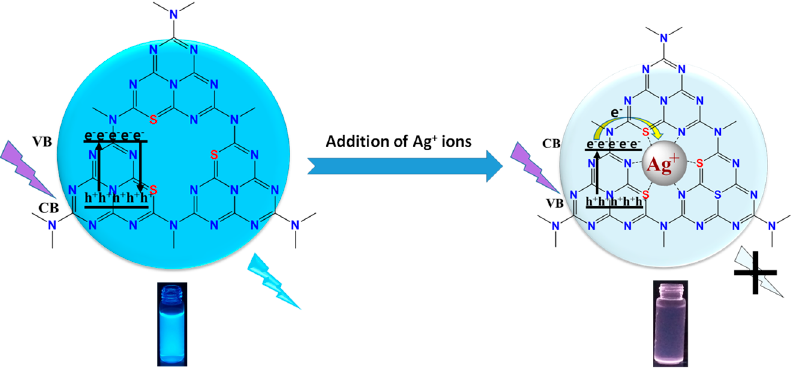
Scheme 1. Schematic illustration of the plausible sensing mechanism of SCNPNS for Ag + ions.